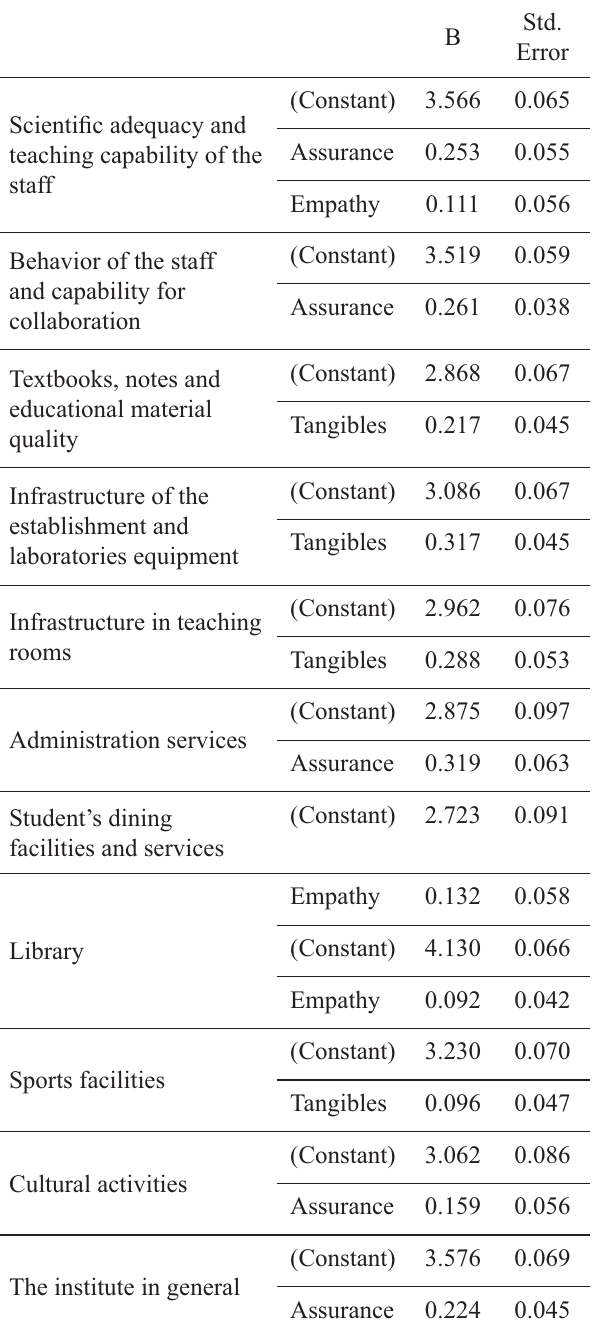
Table 9. Regression models of education issues vs. SERVQUAL dimensions for students’